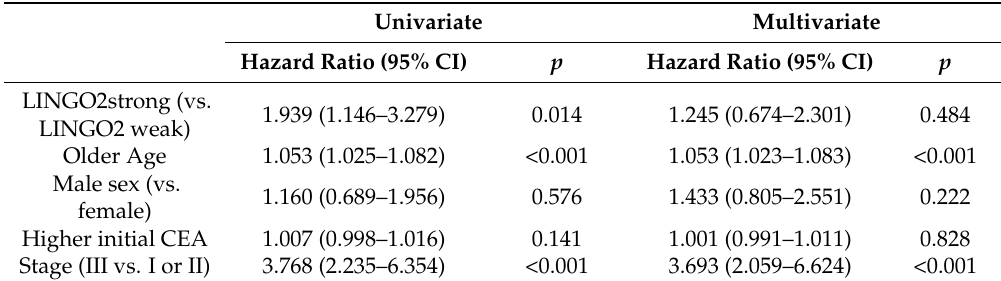
Table 2. Cox proportional hazard analysis for the contribution of clinical factors to OS.